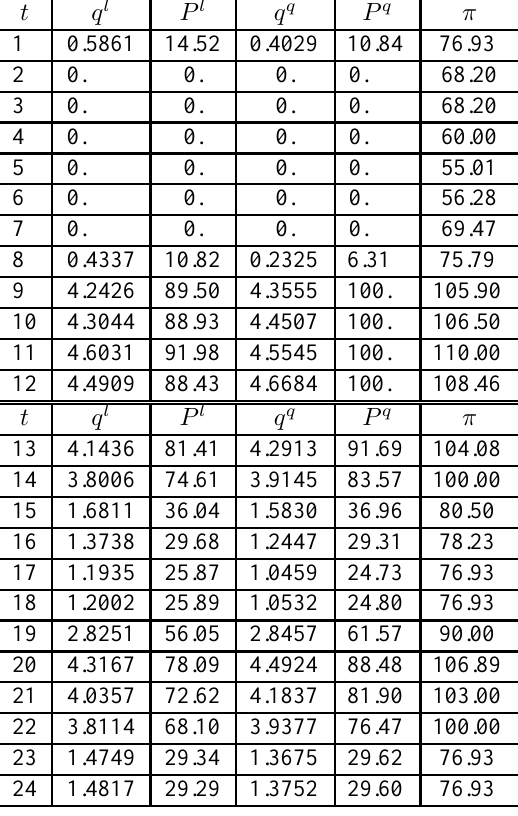
Fig. 4: Two approximations for y(t)